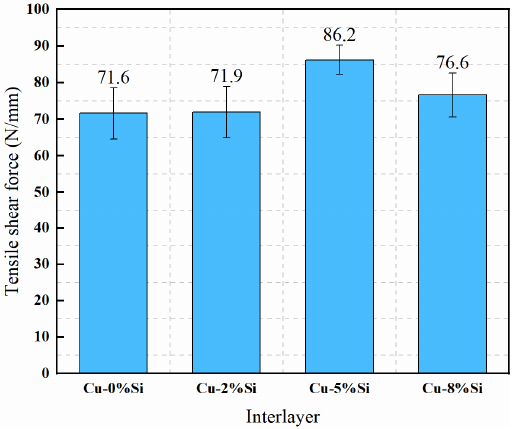
Figure 12. Tensile shear force of the magnesium alloy/steel joint.